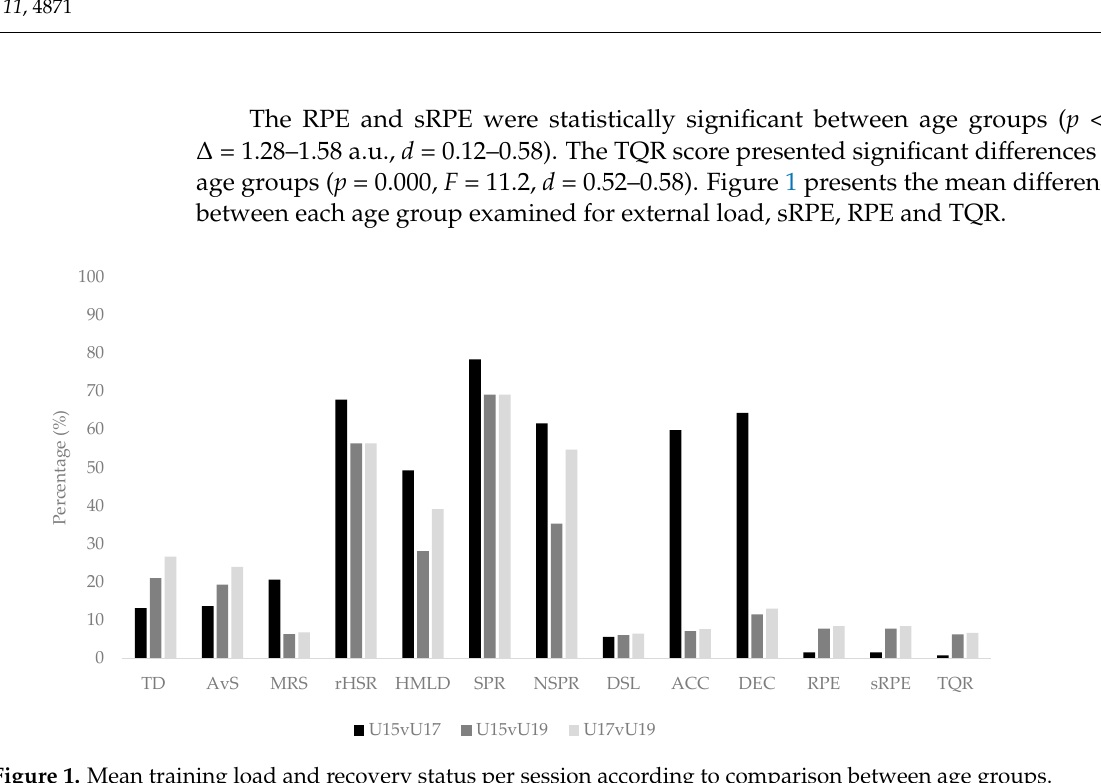
Figure 1. Mean training load and recovery status per session according to comparison between age groups.